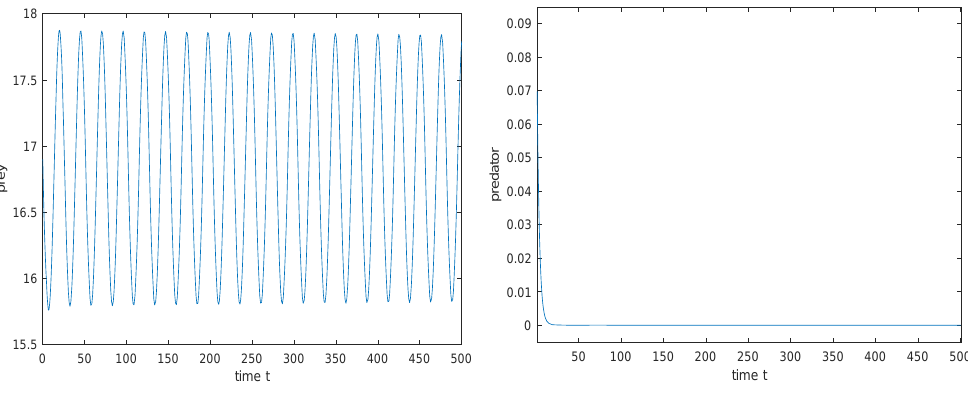
Figure 14. τ = τ ∗ = 5.5939, the supercritical Hopf bifurcation occurs at E 2 . The initial value: ( φ 1 , φ 2 ) = ( 16.9,0.1 )